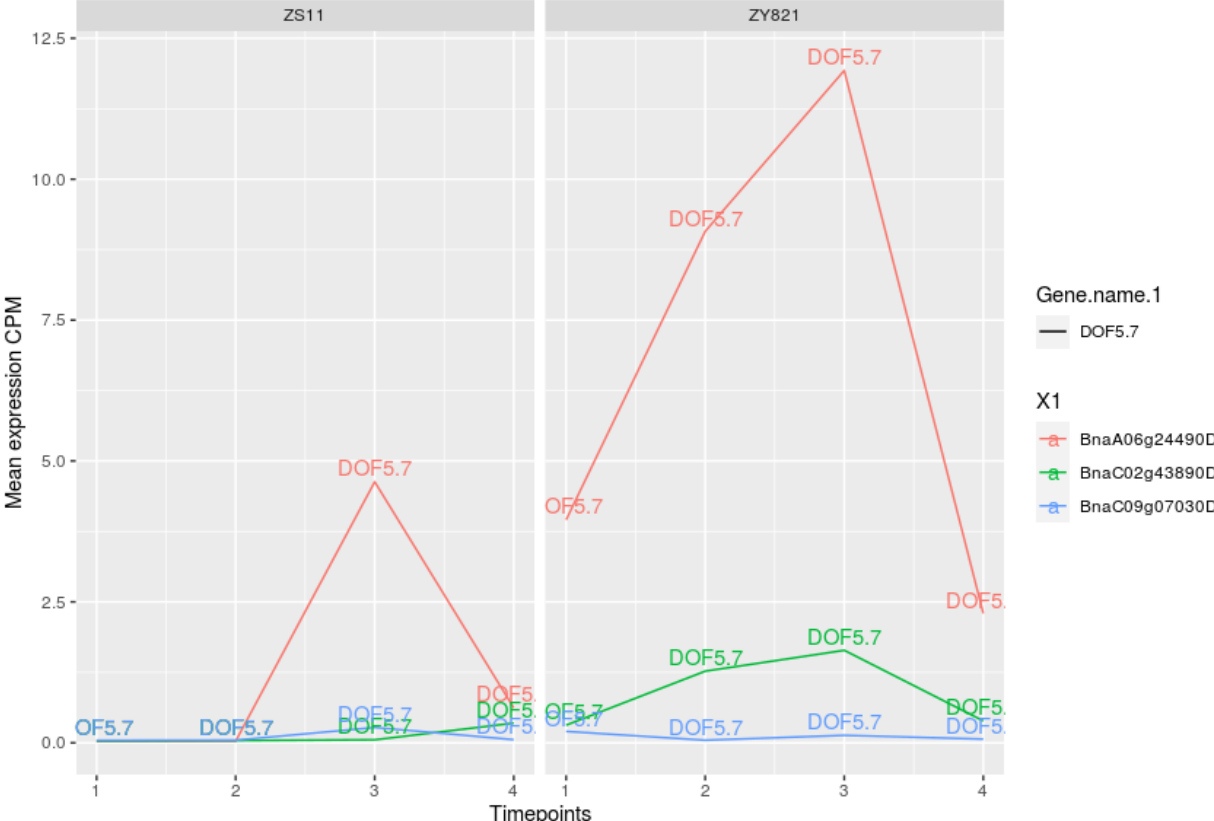
Figure 6. Expression values of DOF5.7 orthologous genes. Time points 1 to 4 represents day 7, day 10, day 15, and day 45 after